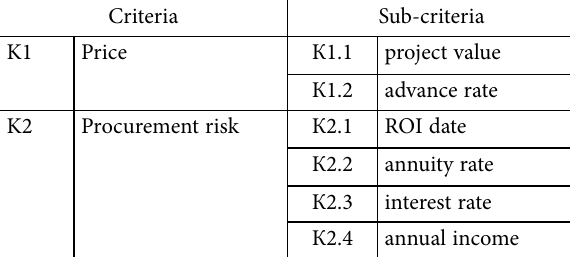
Table 6. Supplier selection additional criteria and sub-criteria